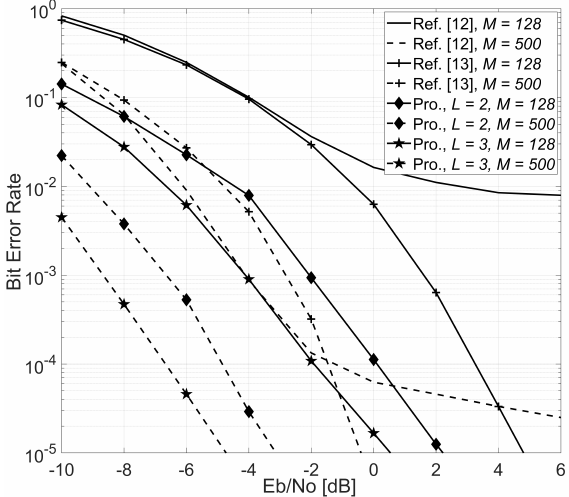
Figure 2. Performance comparison between the proposed 16-DQAM scheme and the previous works of References [12,13] under Rayleigh